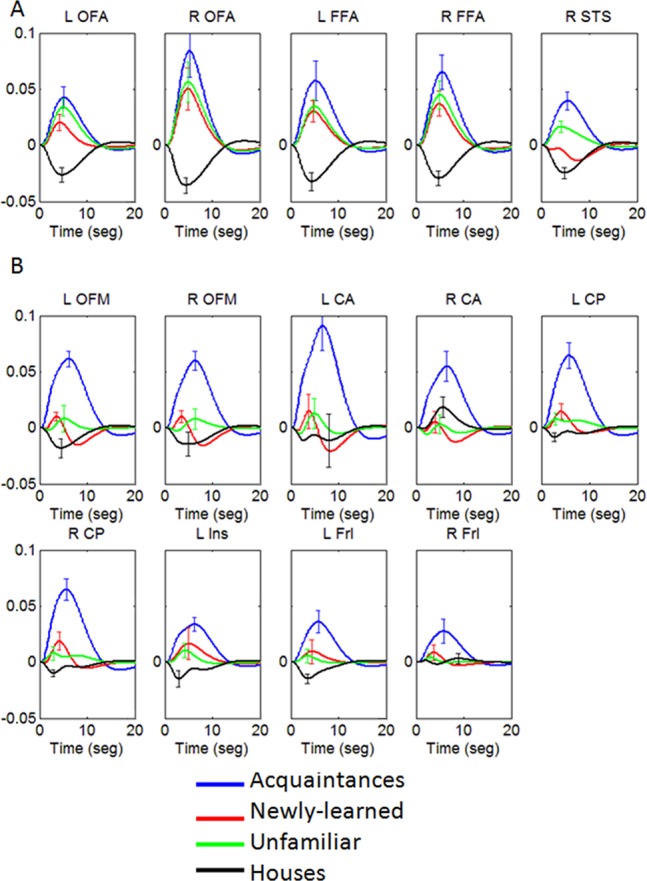
Mean HRFs average across subjects for different face conditions in the selected ROIs.Error bars denote the standard error of the mean.